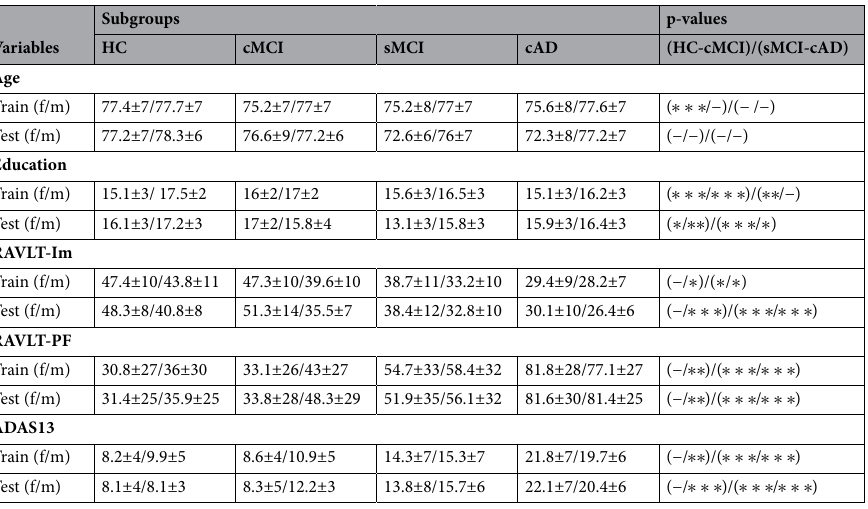
Table 3. Means and standard deviations of age, education level, and scores on the included cognitive tests for each subgroup, given separately for the training and test sets. The information for the converted subgroups (cMCI and cAD) is calculated after removing the measurements from point of conversion and onward. The p-values for pairs of subgroups are presented separately for females and males; ∗ : p < .05; ∗∗ : p < .01; ∗ ∗ ∗ : p < .001; −non-significant at 0.05 level.